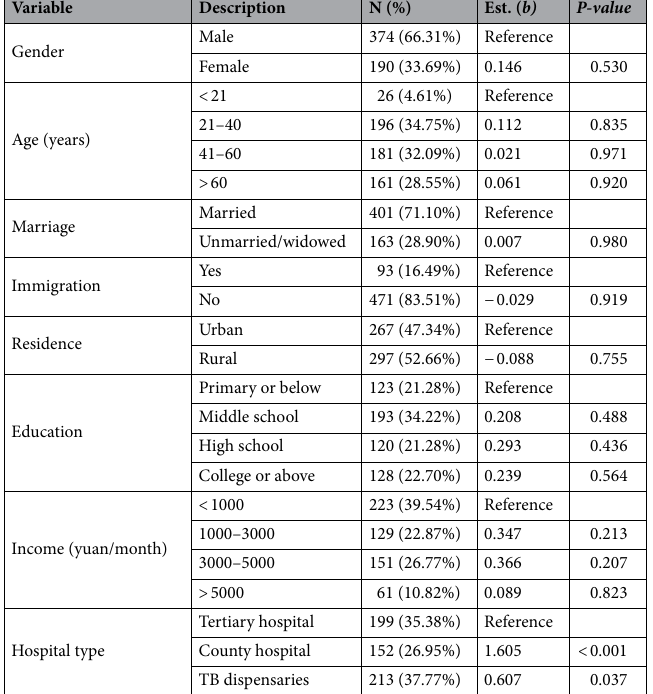
Table 1. Socio-demographic characteristics and the associations with doctor–patient trust.